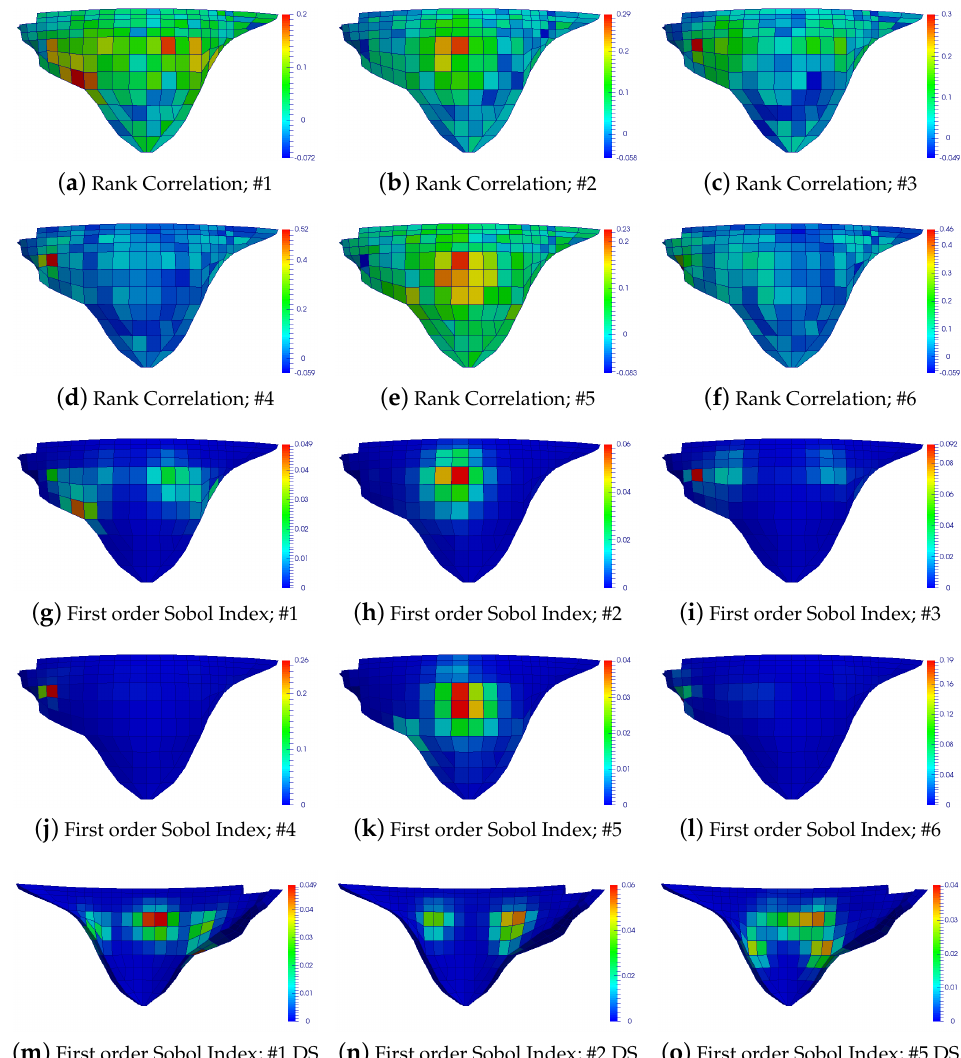
Figure 13. Dam-2; Spatial distribution of sensitive location for different vibration